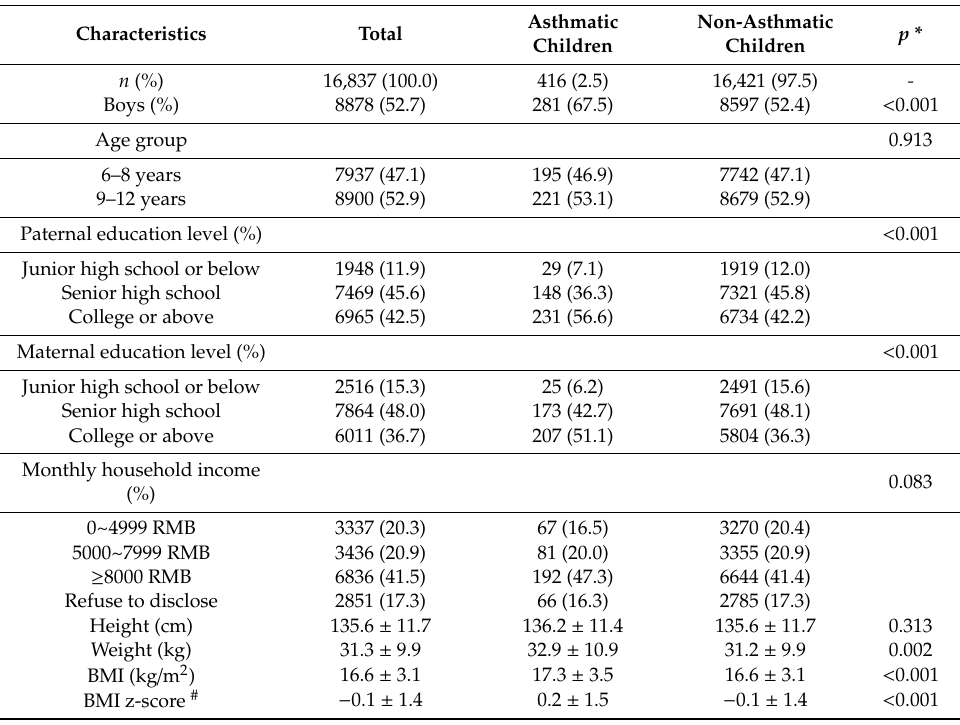
Table 1. Characteristics of the total sample ( n =